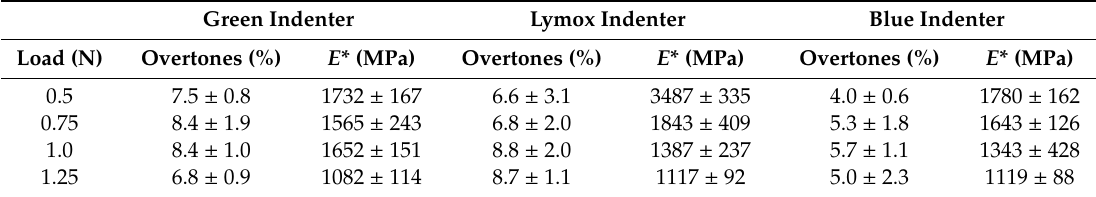
Table 3. Overtones of the first order resonant frequencies of various tungsten cone indenters and complex moduli of high-density polyethylene (HDPE) measured under di ff erent loads. Green Indenter Lymox Indenter Blue Indenter